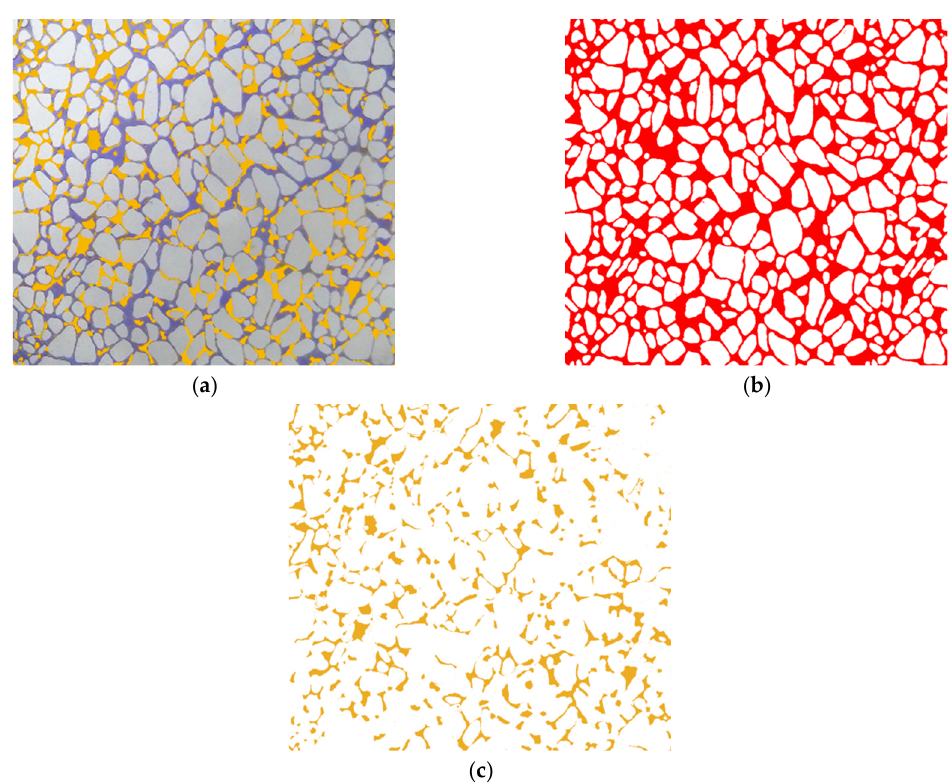
Figure 9. Schematic of quantitative characterization of images based on ImageJ gray analysis. ( a ) Gas-water distribution image after pretreatment; ( b ) Area occupied by voids; ( c ) Area occupied by gas.